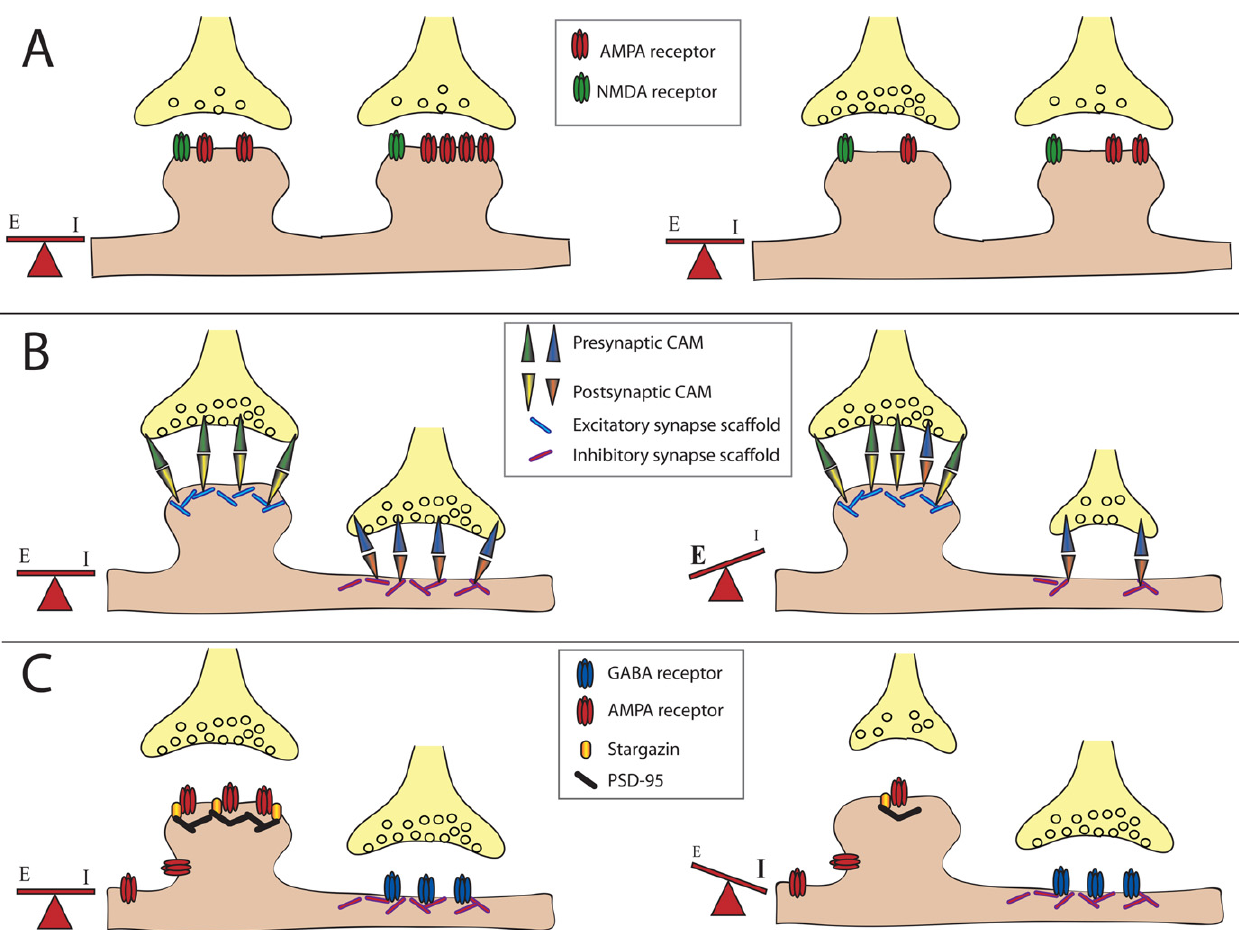
Figure 1. Balancing excitation and inhibition. The majority of excitatory neurotransmitter receptors are presented on bulbous structures known as spines whereas inhibitory neurotransmitter receptors are usually present on postsynaptic sites formed on the dendritic shaft. (A) Homeostatic mechanisms maintain balance. In this example of synaptic scaling an increase in synaptic input results in a decrease in the number of neurotransmitter receptors present at par- ticular synapses to balance changes in synaptic strength. (B) Scaffolding molecules regulate retention of cell adhesion molecules at excitatory vs. inhibitory contacts. Scaffolding molecules retain specifi c adhesion molecules at either excitatory or inhibitory synapses. An example illustrating a loss of a scaffolding molecule that controls retention of adhesion molecules at an inhibitory synapses may cause a reduction in the number of adhesion molecules retained at this site, and a corresponding shift of these adhesion molecules to excitatory synapses. This results in a shift in the E/I balance towards enhanced excitation. (C) PSD-95 regulates retention of AMPA-type glutamate receptors at excitatory synapses. AMPA receptors directly associate with stargazin molecules, which in turn associate with PSD-95. Reduction in PSD-95 levels at the synapse reduces AMPA receptor retention. This results in a shift in the E/I balance towards decreased excitation, or increased